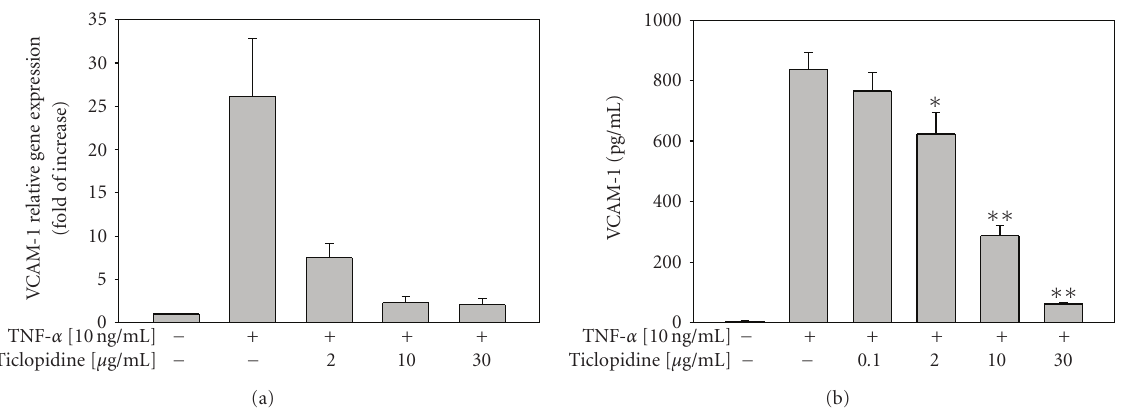
Figure 3: Reduction of VCAM-1 mRNA and protein levels by ticlopidine in HUVECs. HUVECs were incubated with serum-free medium for 12 hours before di ff erent concentrations of ticlopidine were added, after 12 hours incubation cells were stimulated with/without TNF- α (10ng/mL) for another 24hours. (a) Relative amount of VCAM-1 mRNA level was determined by quantitative real-time RT-PCR. (b) Culture supernatants were analyzed by ELISA. Data are expressed as the mean ± SEM of duplicate wells and are representative of three individual experiments. Significantly di ff erent versus TNF-treated alone ∗ P < .05, ∗∗ P < .001.